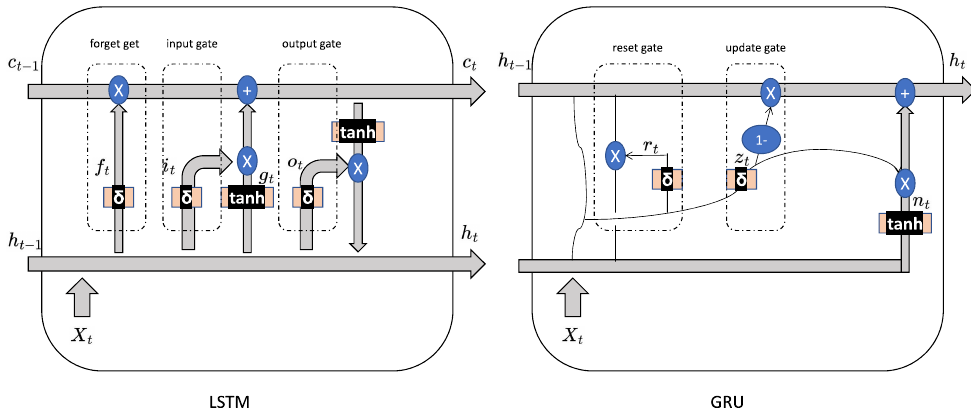
Figure 3. The structure of LSTM and GRU